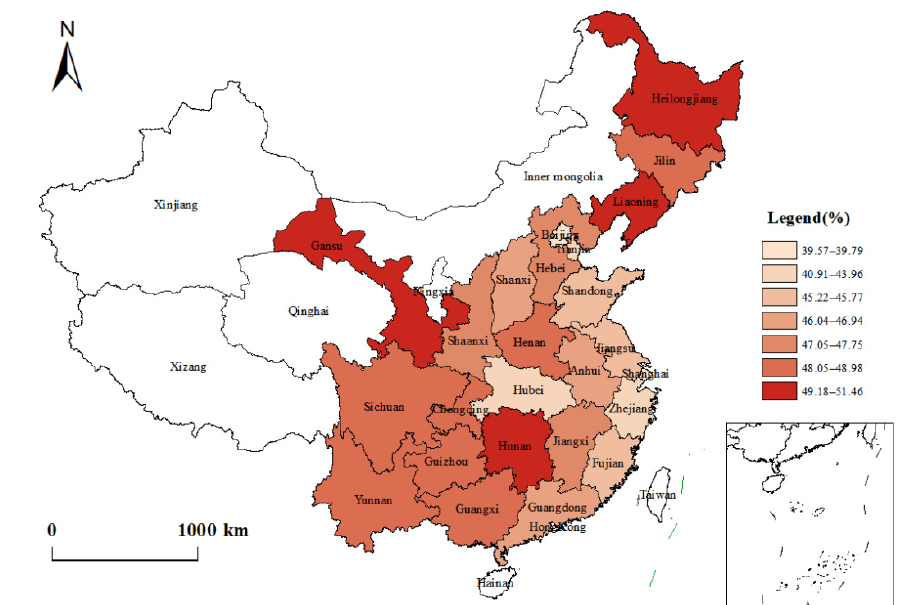
Figure 6. Regional decomposition of health poverty deprivation intensity.